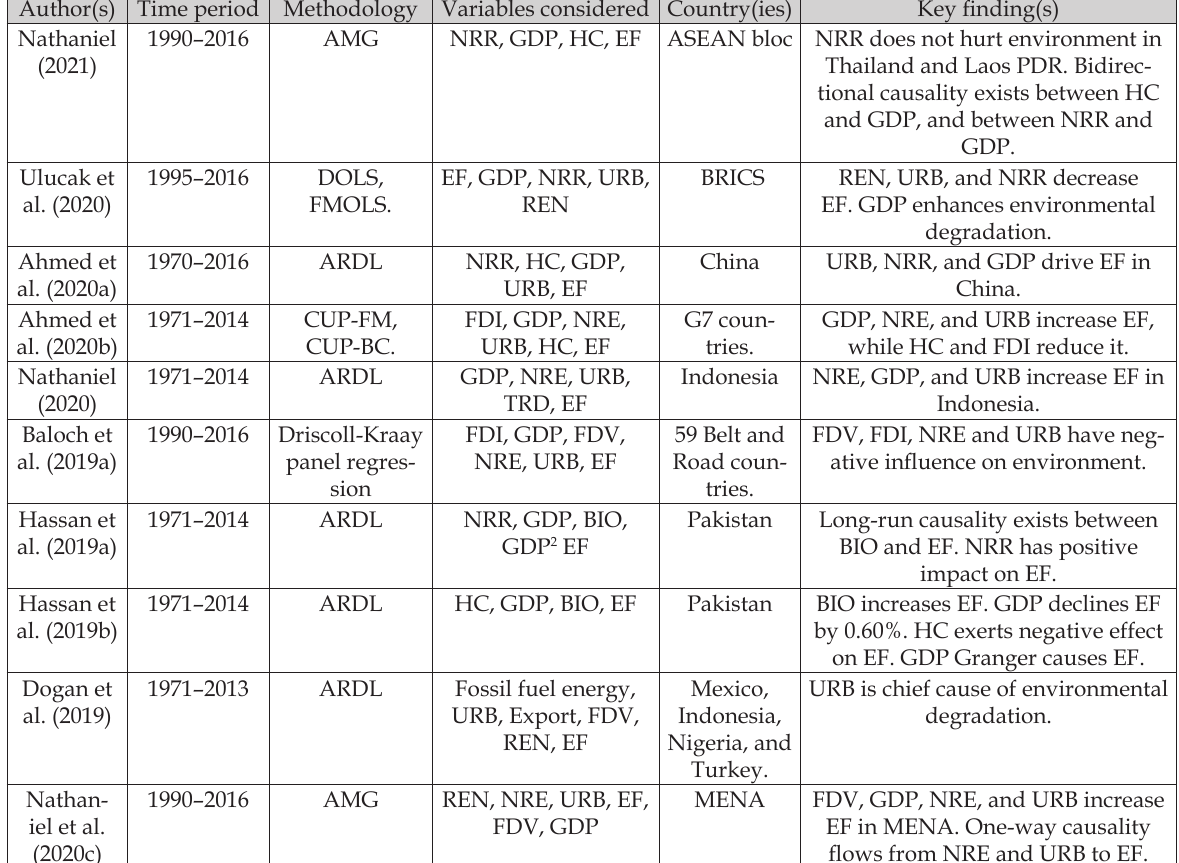
Table 1. Studies on NR, human capital, energy consumption, and the